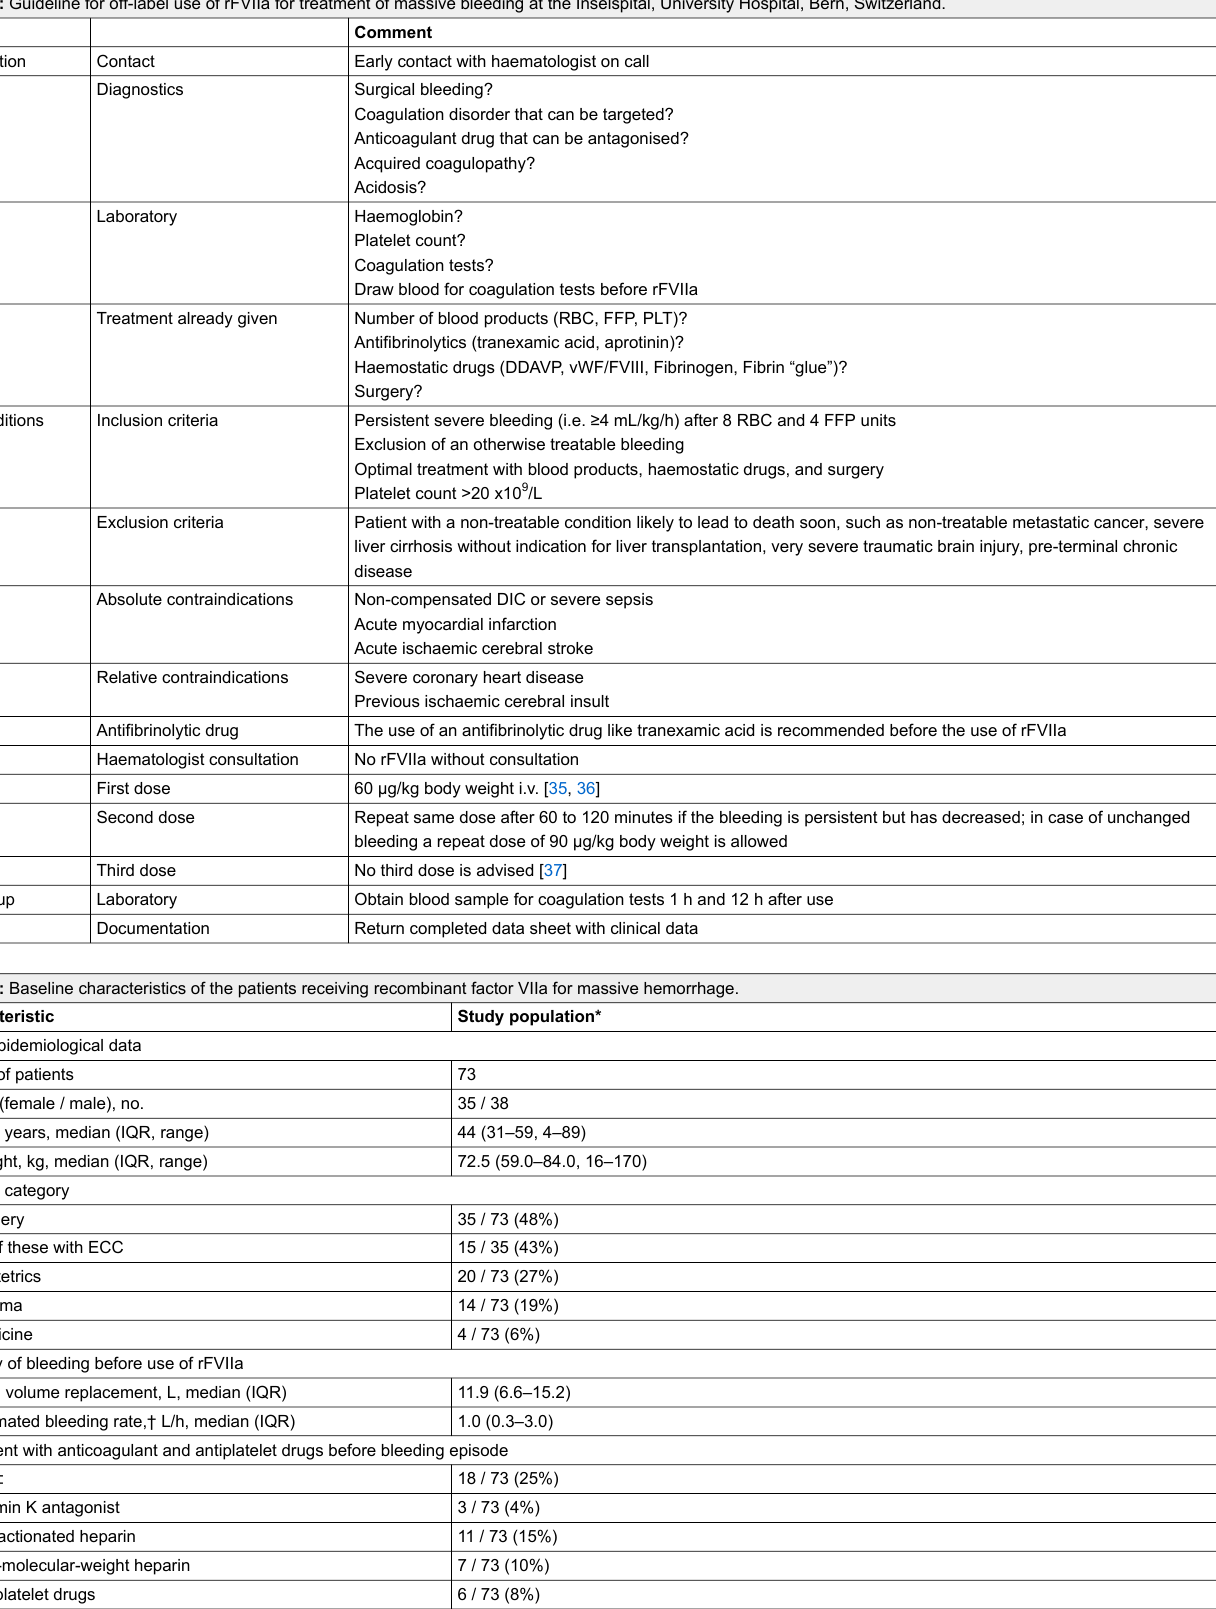
Table 1: Guideline for off-label use of rFVIIa for treatment of massive bleeding at the Inselspital, University Hospital, Bern, Switzerland. Topic